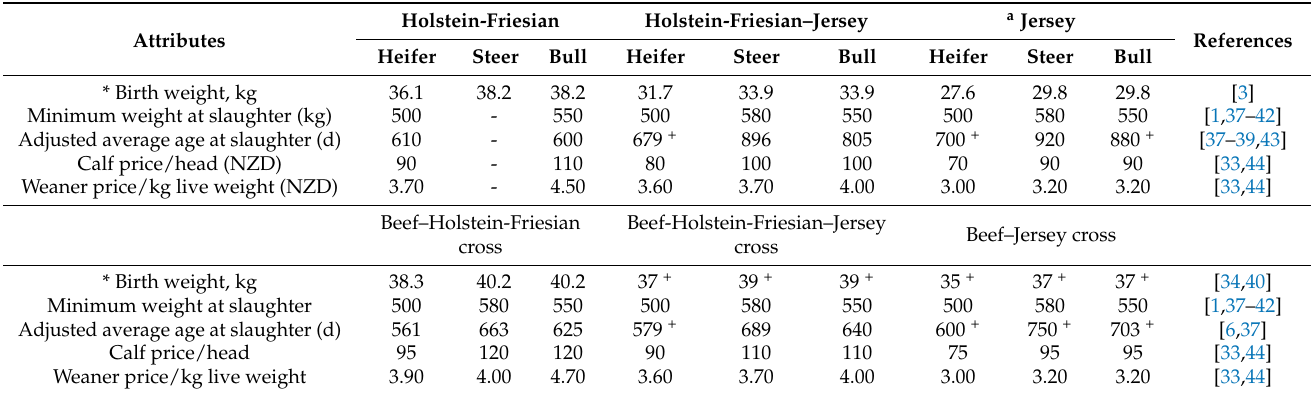
Table 1. Birth weight, minimum weight at slaughter, slaughter age, per head calves, and per kg live weight weaners prices of various classes of dairy-origin beef